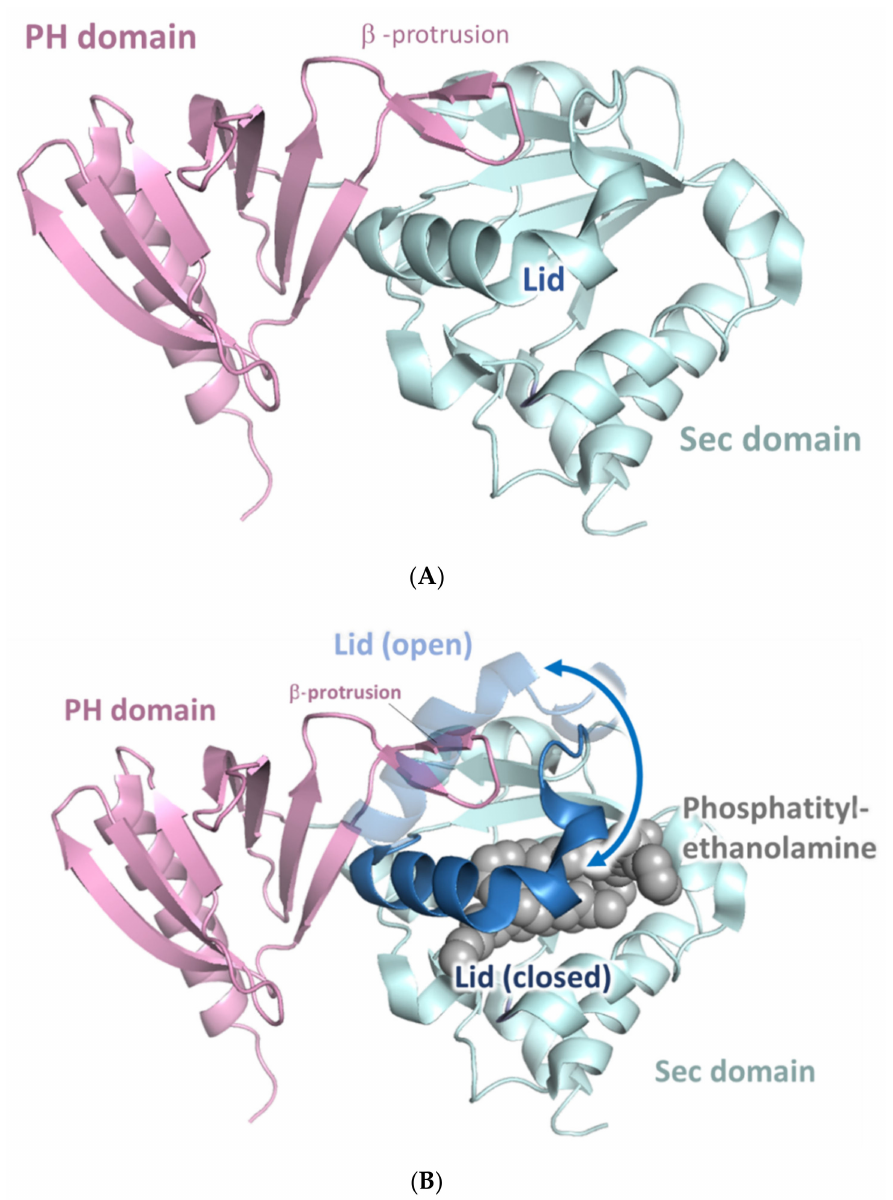
Figure 6. Structure of the SecPH domain: ( A ) Ribbon representation of the SecPH domain of human neurofibromin [50]. ( B ) Ribbon representation of neurofibromin-SecPH superimposed over the open Sec conformation (derived from the structure of Sec14p)